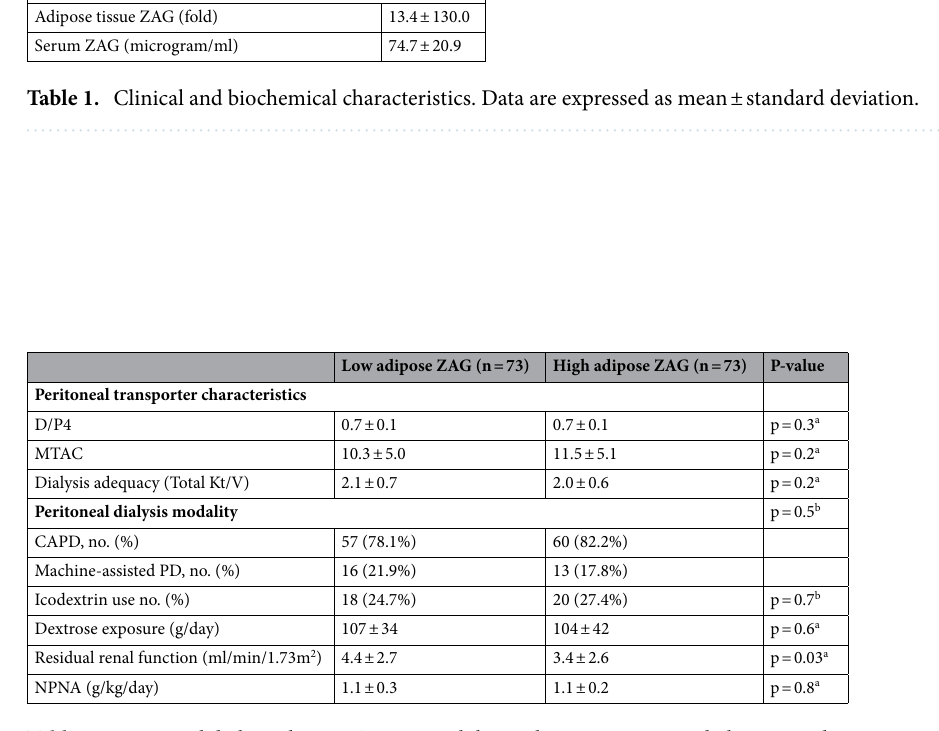
Table 2. Peritoneal dialysis therapy. ZAG zinc alpha-2-glycoprotein, D/P4 dialysate-to-plasma ratio of creatinine at 4th hour, MTAC mass transfer area coefficient of creatinine, CAPD continuous